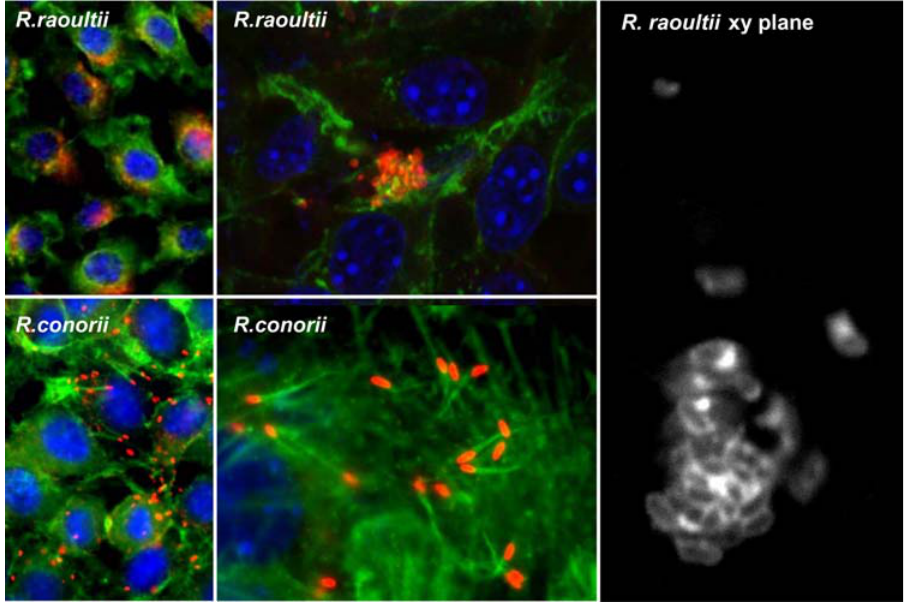
Figure 2. Actin tail phenotypes of R.raoultii and R.conorii in L929 cells. Following a 24 h infection, the bacteria were stained by indirect immunofluorescence using a polyclonal anti-SFG antibody followed by an anti-mouse-Alexa 594 Ig as a secondary antibody (red). F-actin was stained with FITC-phalloidin (green) and nucleic acids were stained with DAPI (blue). Examination of slides with a Leica DM2500 Upright fluorescent microscope (magnifications 40 6 and 100 6 ), showed that R. raoultii formed microcolonies and multiplied at the center of the cell while R. conorii exhibited actin tails at one pole of the bacterium. The right panel corresponds to a higher-magnification image of R. raoultii microcolony observed with a Leica SPE upright confocal microscope.